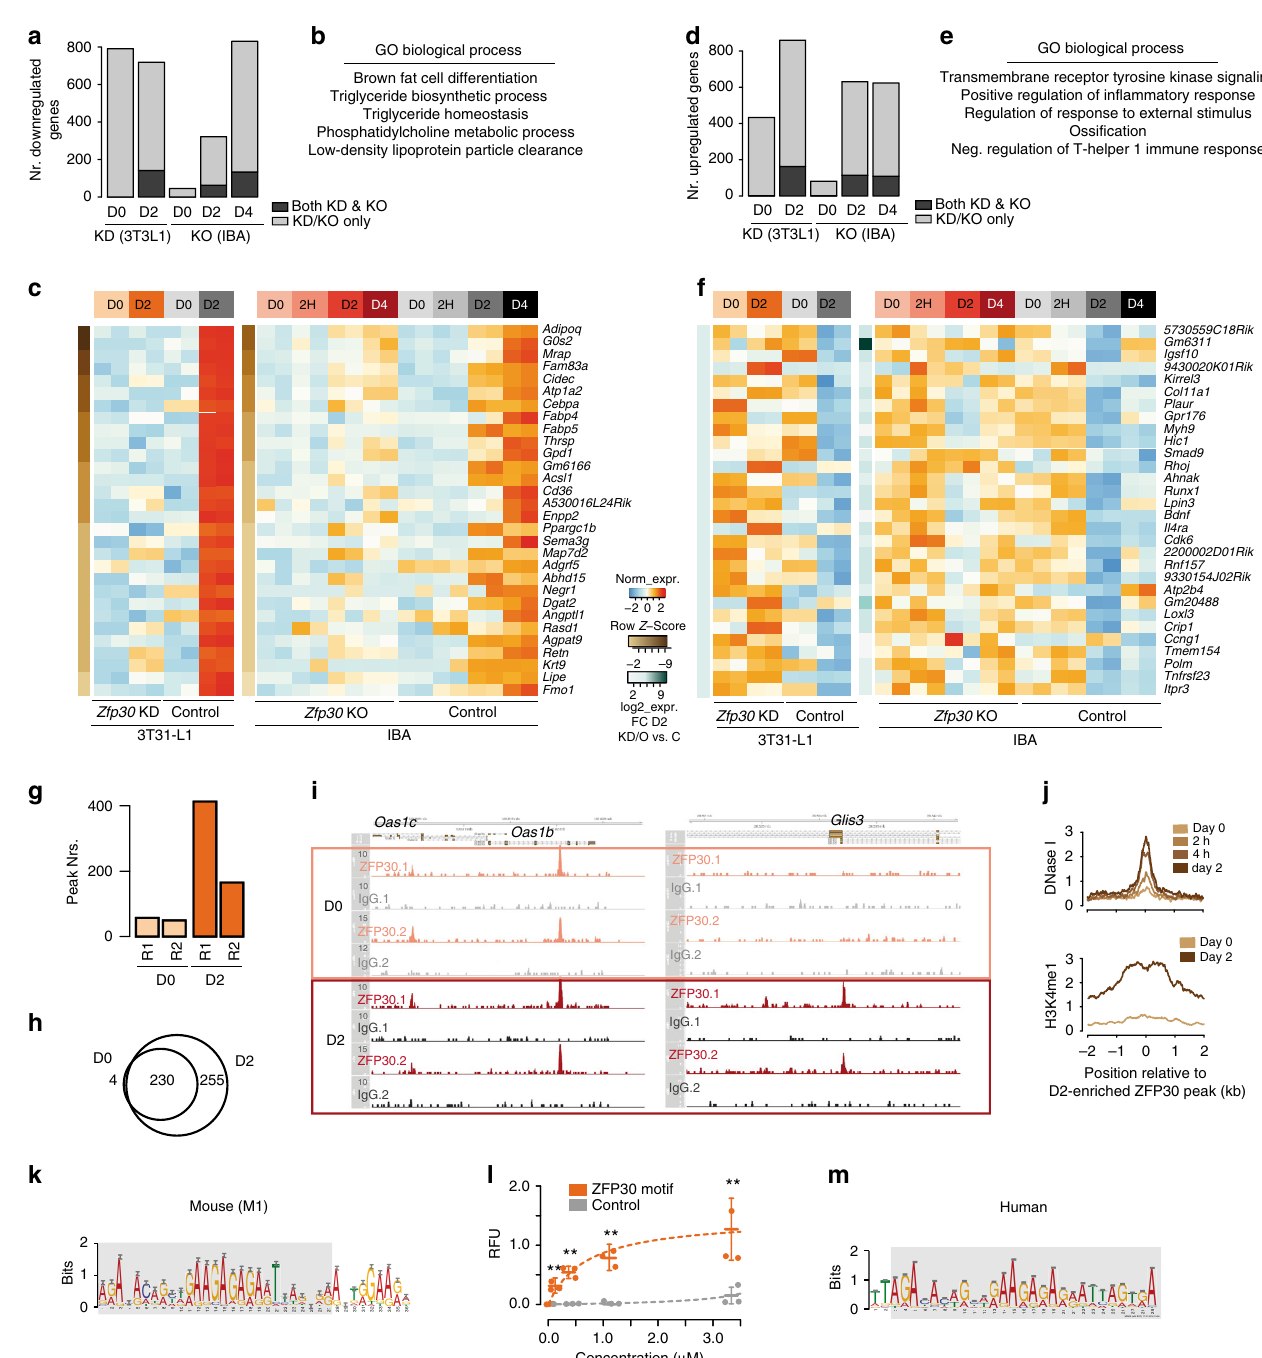
Fig. 2 ZFP30 regulates multiple targets during adipogenesis. a, d Number of genes signi fi cantly (FDR 0.1, |FC| 2) down- ( a ) or up- ( d ) regulated upon Zfp30 KD in 3T3-L1 cells at days 0 and 2 upon adipogenesis (left) as well as Zfp30 KO in IBA cells at days 0, days 2, and 4 upon adipogenesis (right) (light gray). The number of commonly deregulated genes is depicted in dark gray. b,e Gene Ontology (GO) biological processes enriched among the genes commonly down- ( b ) and up- ( e ) regulated upon Zfp30 KD and KO at days 2 or 4. c, f Heatmap displaying the top 30 genes commonly down- ( c ) and up- ( f ) regulated upon Zfp30 KD and KO at days 2 or 4, ordered based on FCs in day 2 KD samples. g Number of ZFP30-HA ChIP-seq peaks in 3T3-L1 cells at days 0 and 2. Two biological replicates (R1 and R2) were performed. h The overlap between ZFP30-HA ChIP-seq peaks at days 0 and 2. i Examples of ZFP30-HA DNA binding at the Oas1 gene cluster (adipogenic-invariant binding) and Glis3 locus (adipogenesis-induced binding). j DNase I hypersensitivity (upper panel) and H3K4me1 (lower panel) signal upon adipogenic induction in a 4 kb window centered around the point of maximal ZFP30 binding, at locations bound by ZFP30 at day 2 only. k Top de novo motif (M1) discovered in DNA sequences bound by ZFP30 in mouse 3T3-L1 cells. l In vitro ZFP30 binding to DNA oligos bearing the consensus M1 motif as well as a control sequence, as assessed using MITOMI. The quantities of bound DNA are expressed in relative fl uorescent units (RFU), normalized by protein amount. n = 3 biologically independent experiments. ** p < 0.01, t test. m Top de novo motif discovered in DNA sequences bound by ZFP30 in human HEK239T cells. All panels: error bars — SD. Source data are provided as